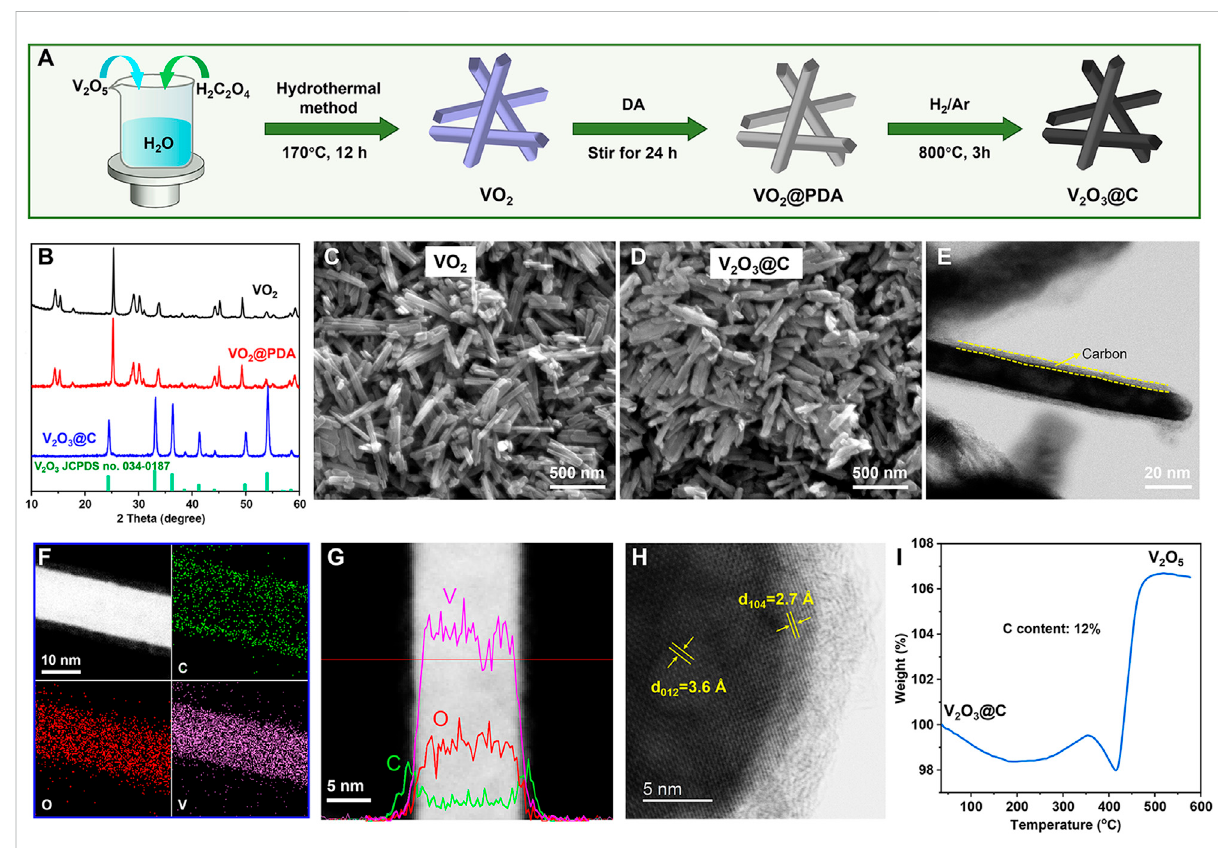
FIGURE 1 (A) Schematic illustration of the synthetic route for V